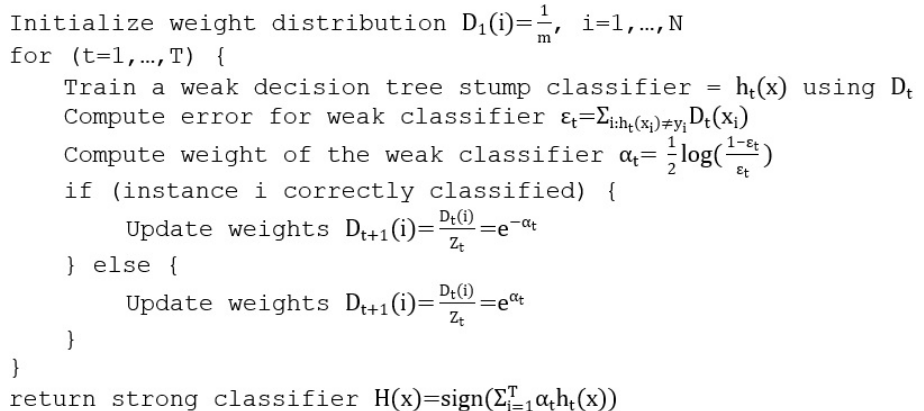
Figure 8. ABDT pseudocode.